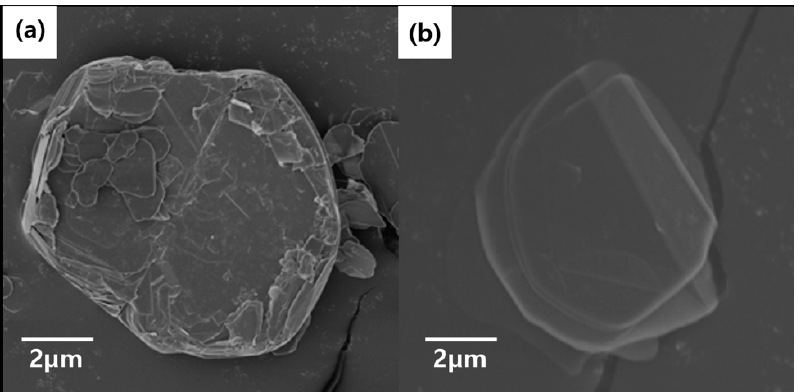
Figure 3. Field emission scanning electron microscope (FE-SEM) image of raw BN particles ( a ), and BN–OH particles ( b ).